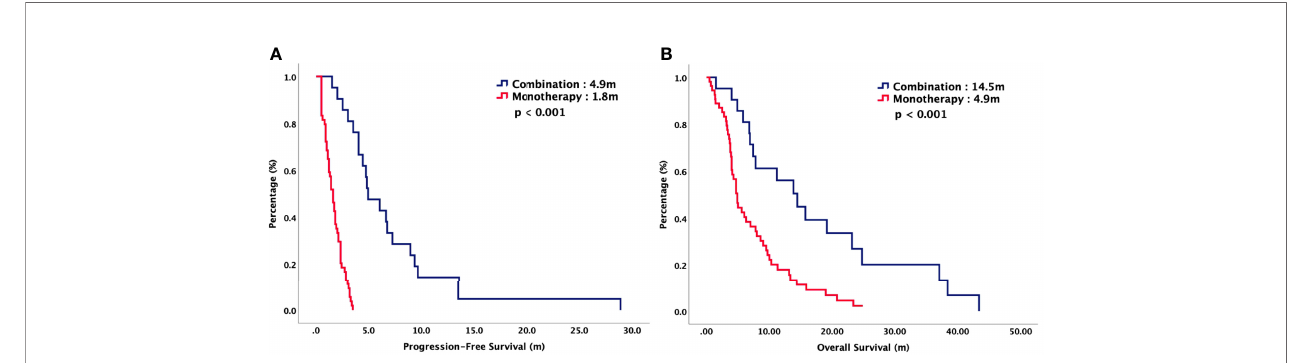
FIGURE 3 | (A) Progression-free survival and (B) overall survival of patients with chemorefractory mCRC treated with REG, strati fi ed by combination